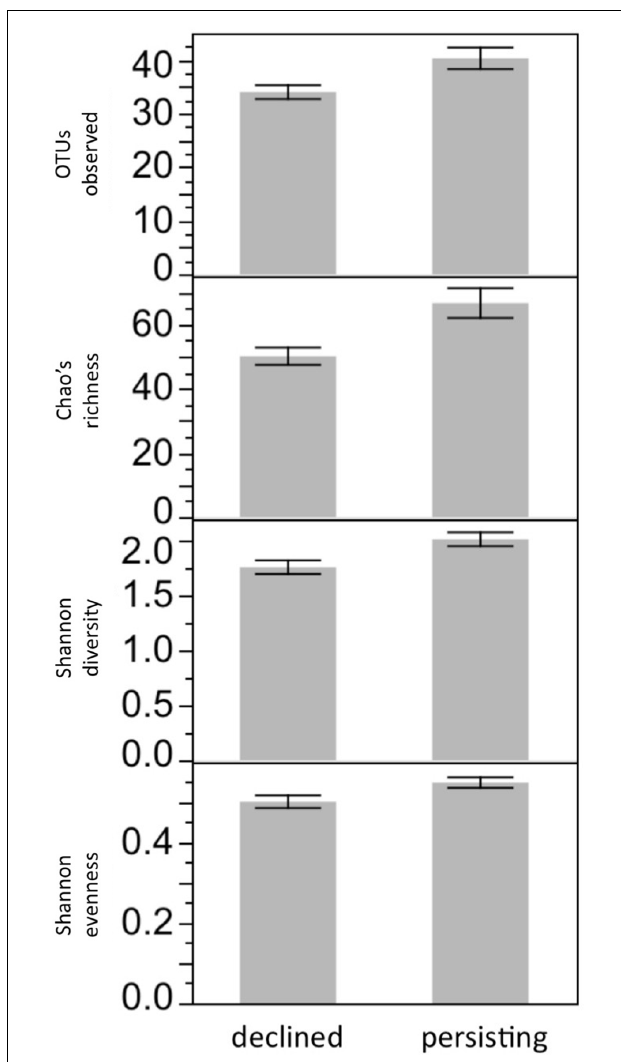
FIGURE 4 | Microbiome diversity is affected by Lake Water Type. After 3 weeks of exposure to water treatments, bacterial diversity was higher on R. sierrae housed in water that had been collected from lakes inhabited by persisting frog populations, compared with frogs housed in water collected from lakes that had been inhabited by populations that died out due to Bd. P < 0.05 for all four richness or diversity